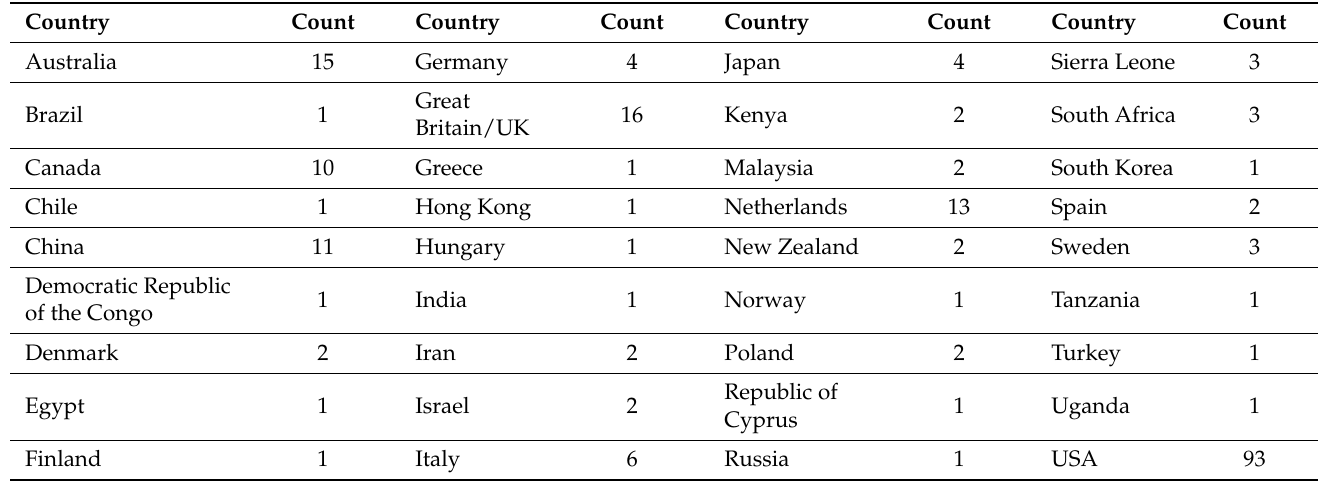
Figure 2. Number of Publications per Year (1973–2021). Table 2. Number of Studies from Different Countries/Regions.